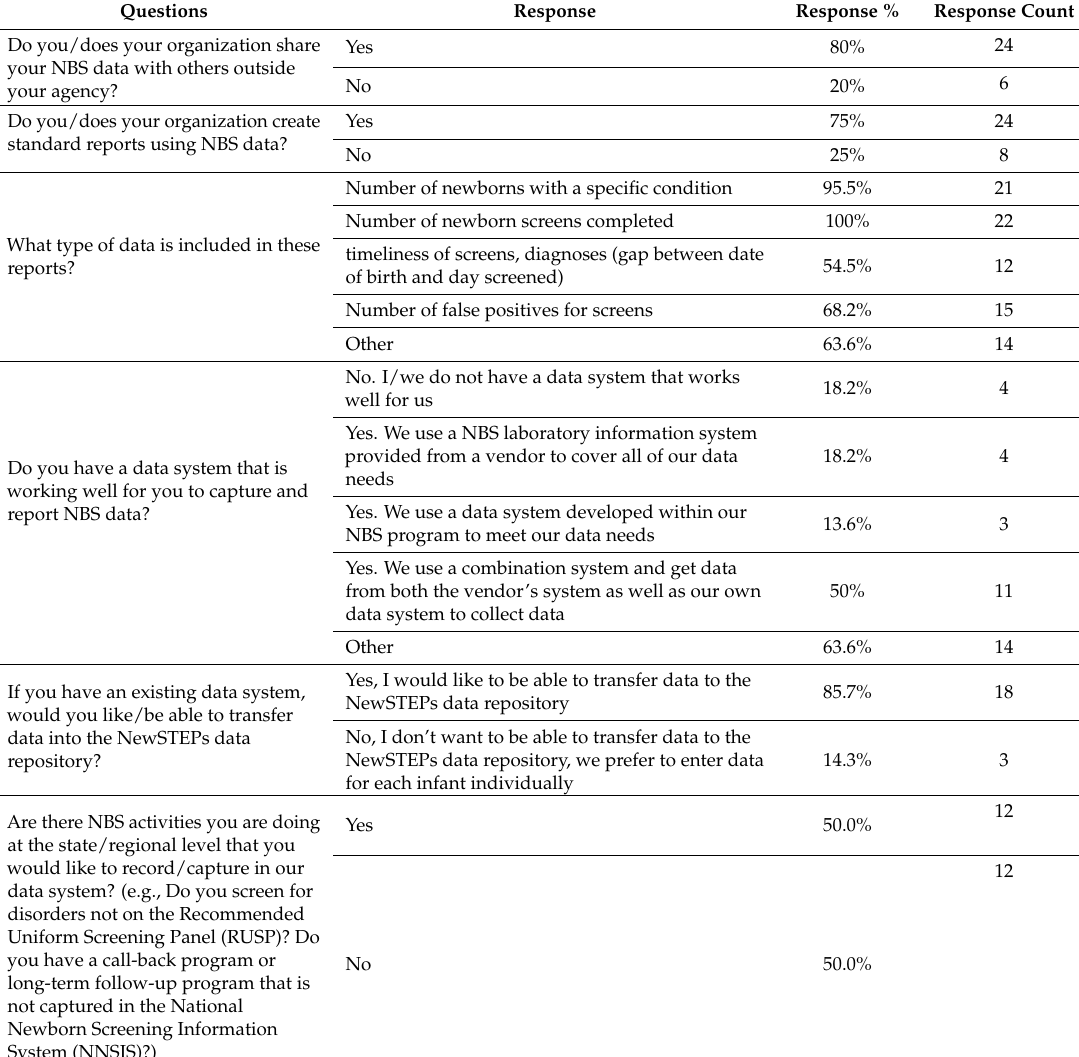
Table 3. Summary Data from 2012 Newborn Screening (NBS) Data Use